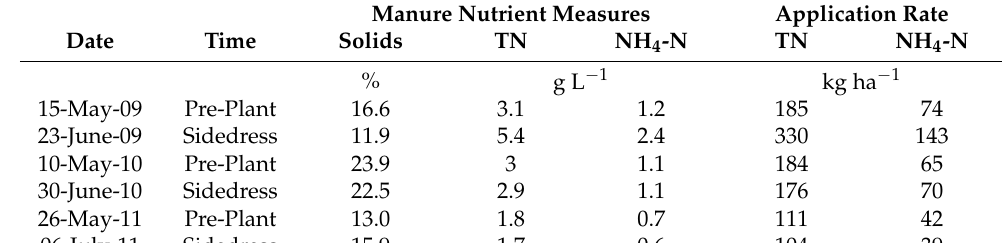
Table 1. Manure application dates, nutrient measures, and application rates.